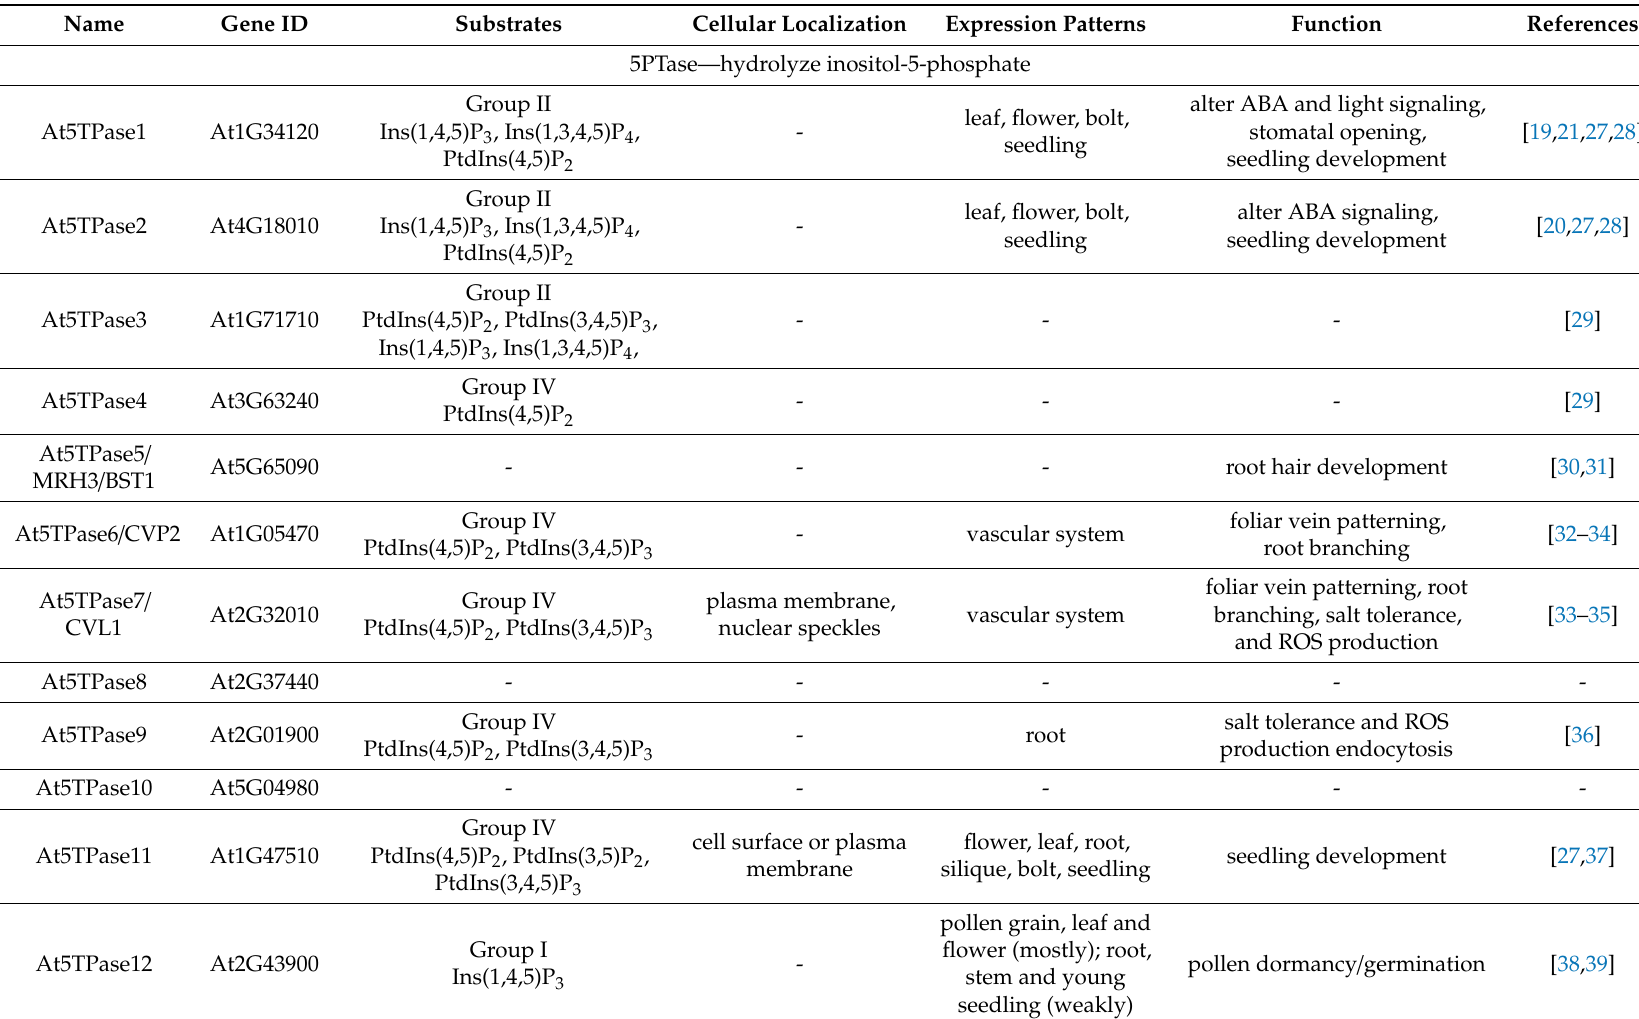
Table 1. Phosphatases of the inositol signaling pathway in Arabidopsis thaliana